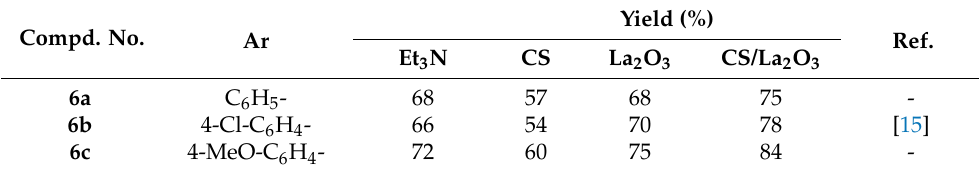
Table 3. Yield percent of products 6a – c.